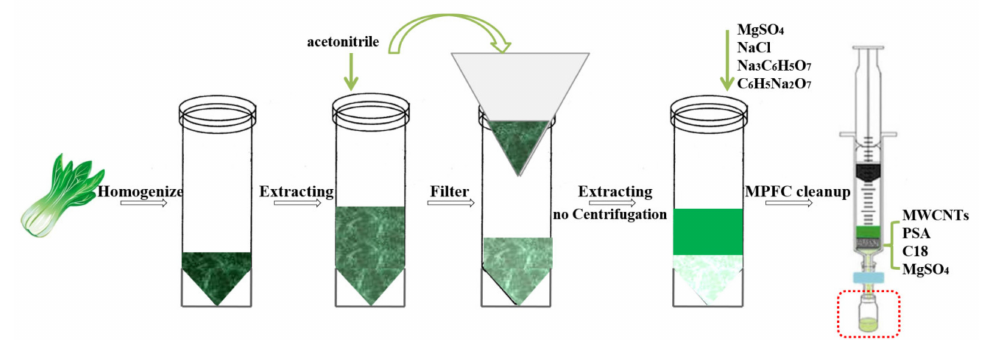
Scheme 1. Schematic diagram of in situ sample-processing methods for rapid simultaneous detection of pesticides in